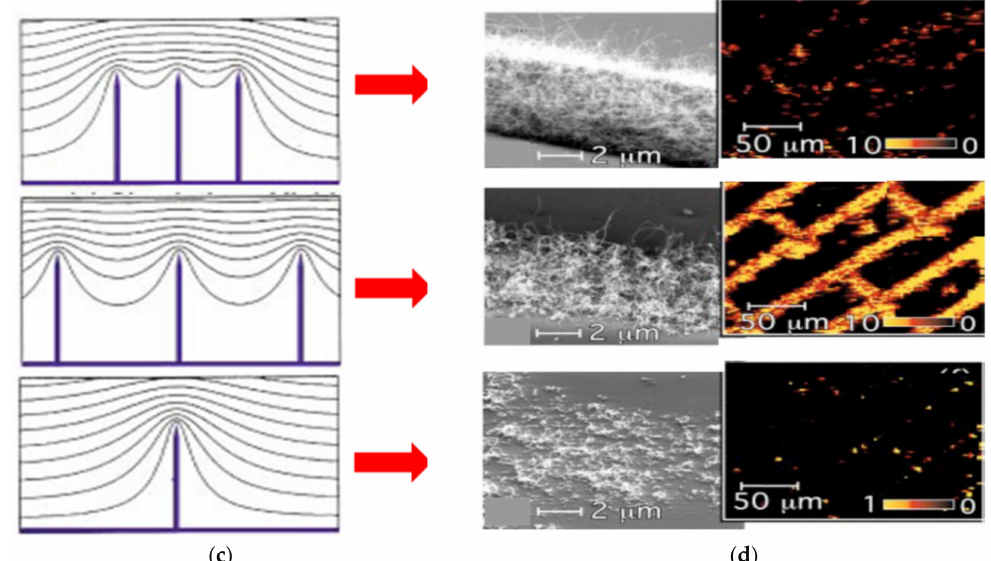
Figure 3. The FE cathodes made of a CNT matrix: ( a ) an SEM image of the dispersed CNT laminated onto a 50 × 50 µ m 2 area, the inset—the schematic illustration presenting the CNTs matrix laminated between two glass slides (reprinted with permission from [86]); ( b ) an SEM image of FE cathode made by ink-jetting of dispersed CNTs—the inset presents a macroscopic emission image of 2.5 × 2.5 mm 2 on the phosphor screen; ( c ) the illustration presenting the field screening e ff ect issue—a simulation of the electric field penetration depth for various CNT inter-distances; ( d ) SEM images (left) and FE maps (right) of the FE film cathodes, relevant to simulations presented in ( c )—from the top to the bottom: the FE film with the highest, medium, and the lowest density of CNTs. Figure 3b–d reprinted with permission from